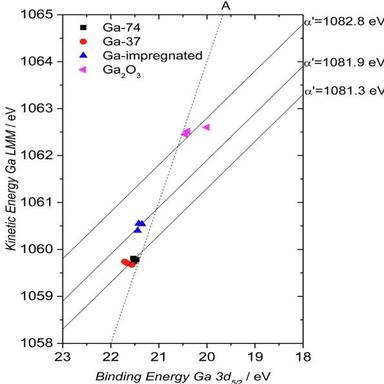
Wagner plot (Ga LMM Auger vs. XPS Ga3d5/2) of Ga-74, Ga-37, Gaimpregnated and gallium oxide.